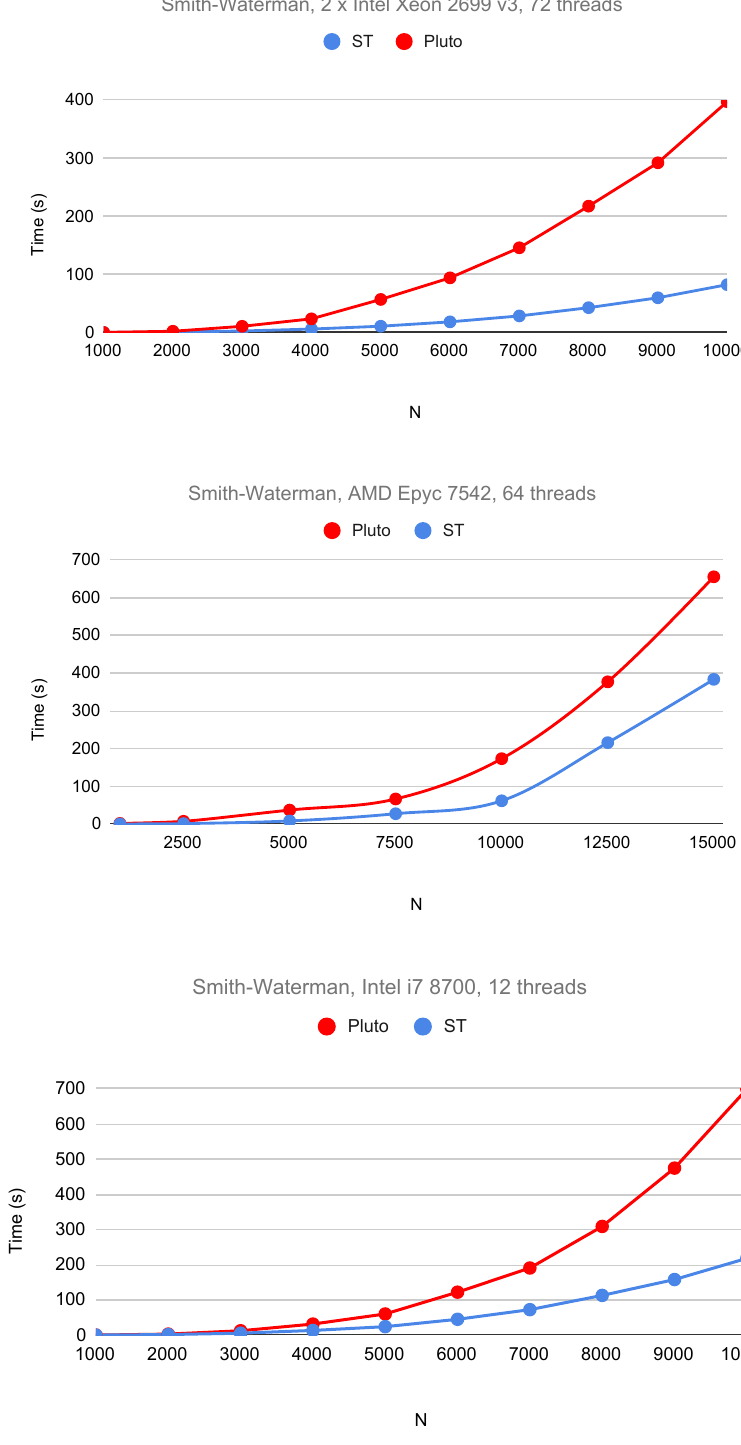
Figure 2. Running times of the parallel tiled Smith–Waterman implementations generated by apply- ing space-time tiling and